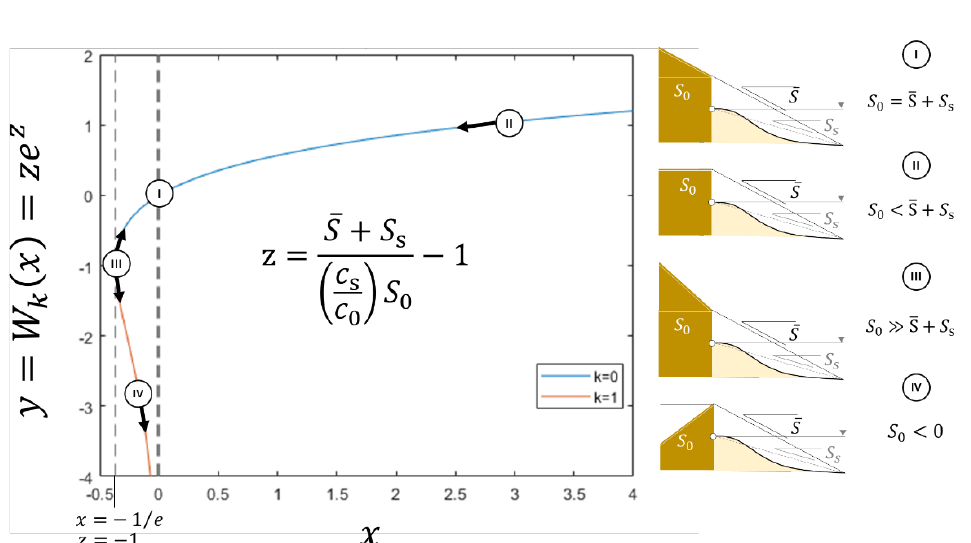
Figure 5. Graph of the two real branches of Lambert W k = 0,1 function and geometrical interpretation based on our simple cli ff -shoreface model assuming ( c 0 / c s ) = 1 or that cli ff and shoreface sediment composition are the same. The black arrows indicate the direction towards which an initial state will evolve over time. Points I, II and III are all on the principal branch W k = 0 , and all tend toward equilibrium (x = 0), while Point IV is the only one over W k = 1 and represents an unstable point that will evolve towards - ∞ over time.